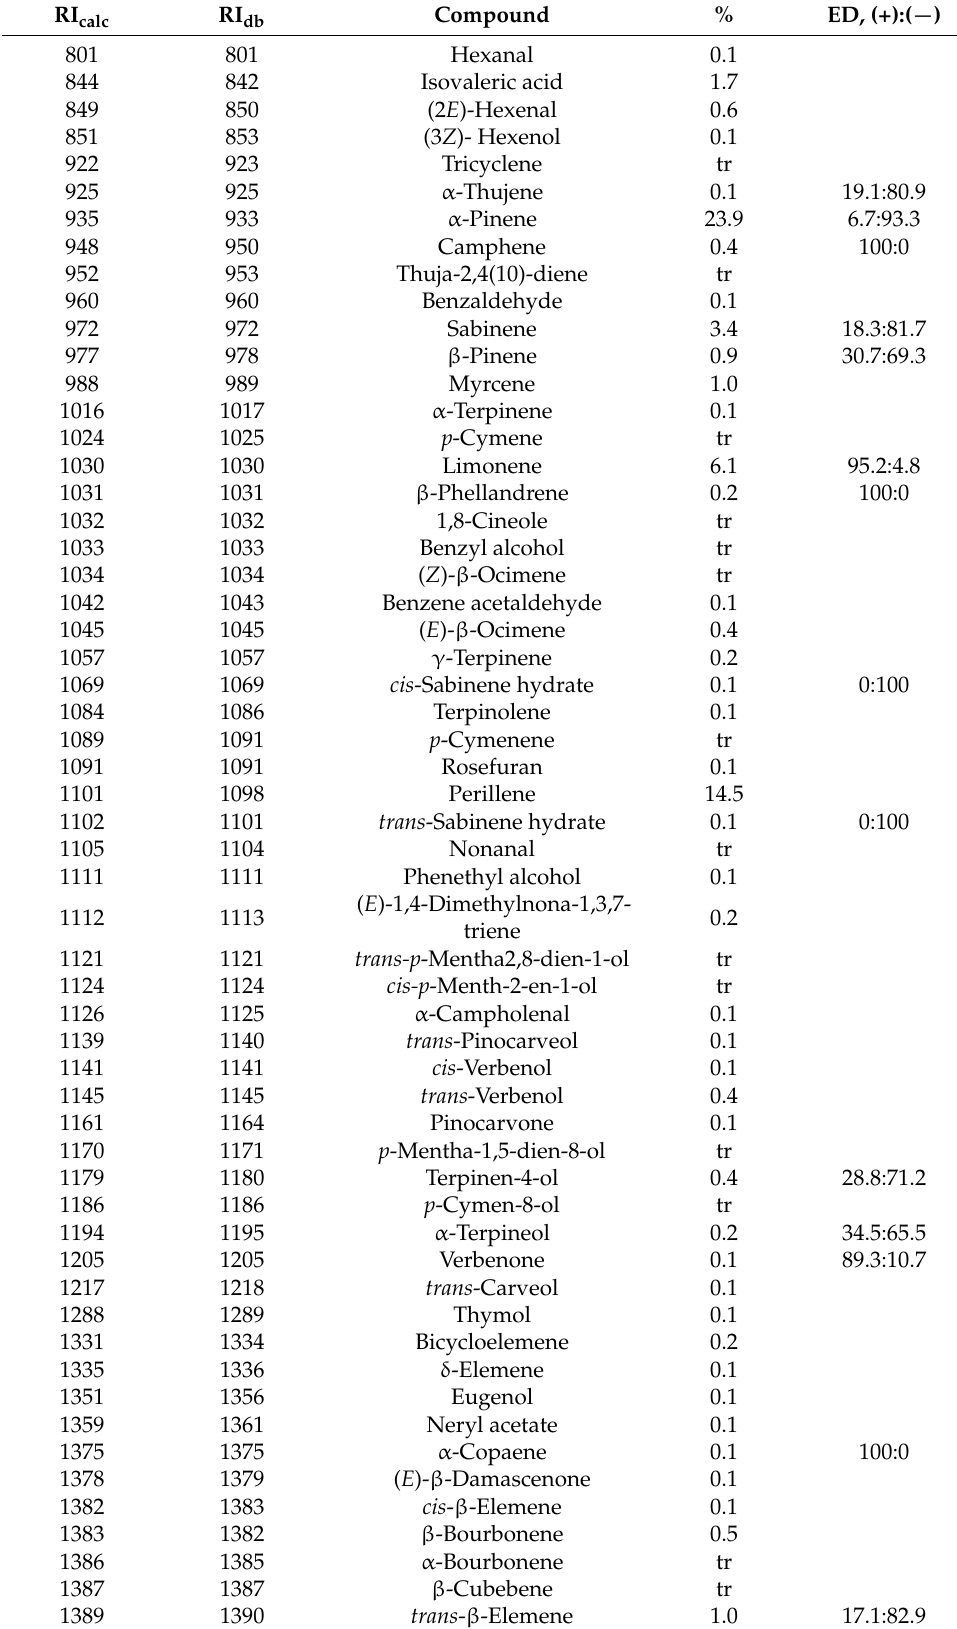
Table 7. Essential oil composition of Smallanthus uvedalia from South